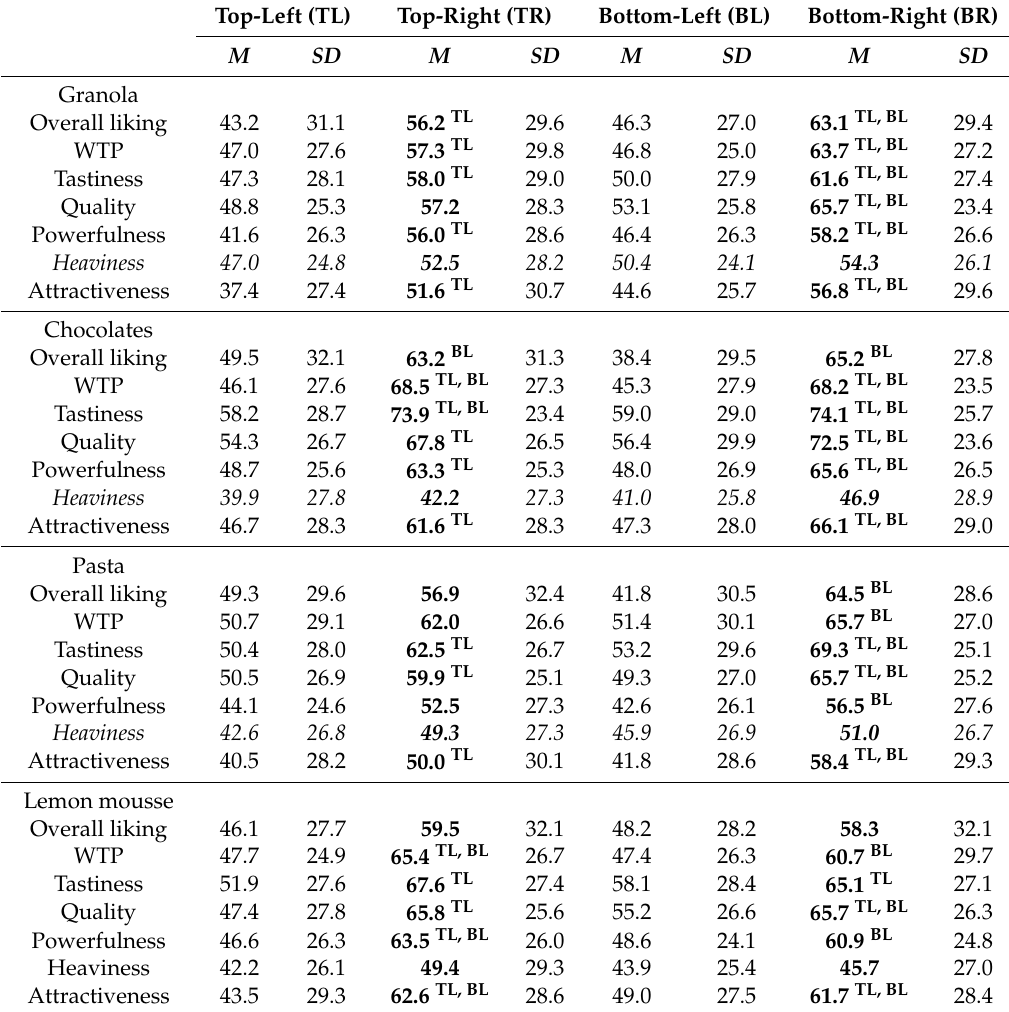
Table 2. Results for the ‘quarter-window’ (top-left/top-right/bottom-left/bottom-right) stimuli by